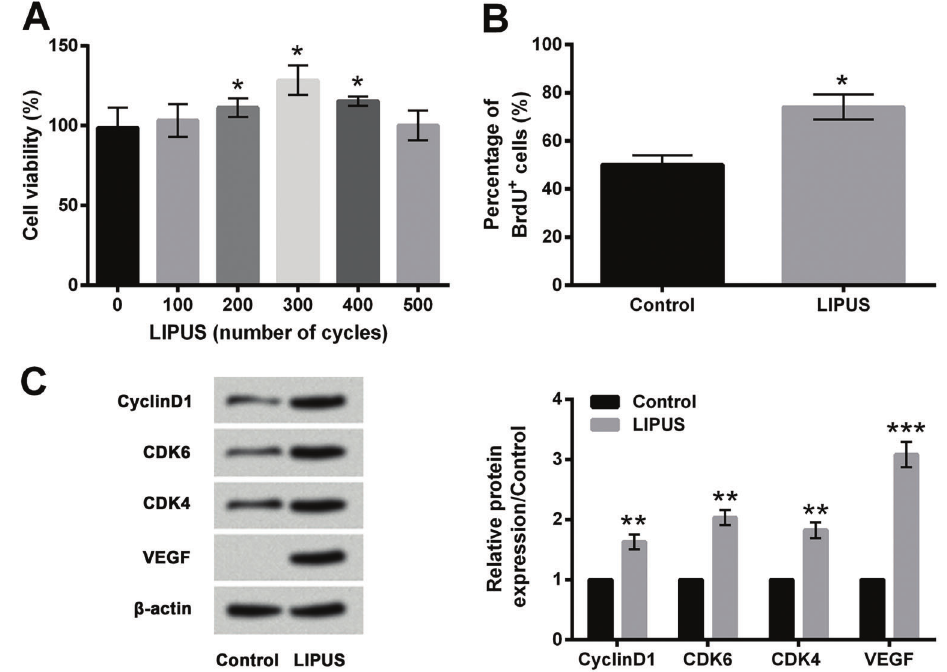
Figure 1. Low-intensity pulsed ultrasound (LIPUS) promoted proliferation of HaCaTcells. The parameter of LIPUS stimulation (number of cycles) was set at 100 – 500. A , HaCaT cell viability was determined by CCK-8 assay. B , Percentage of BrdU positive cells was evaluated by BrdU incorporation assay. C , Expression of proteins associated with proliferation was evaluated by western blot analysis. Data are reported as means ± SD of three independent experiments. *P o 0.05, **P o 0.01, ***P o 0.001 compared to control (Student ’ s t